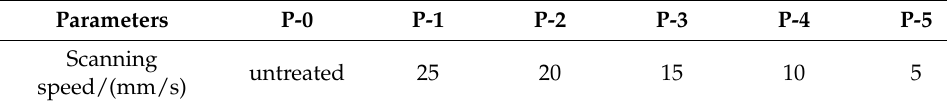
Figure 1. Laser scanning path: ( a ) perpendicular to stretching direction, ( b ) parallel to stretching direction. Table 3. Al–Li alloy sample numbers and corresponding treatment methods.